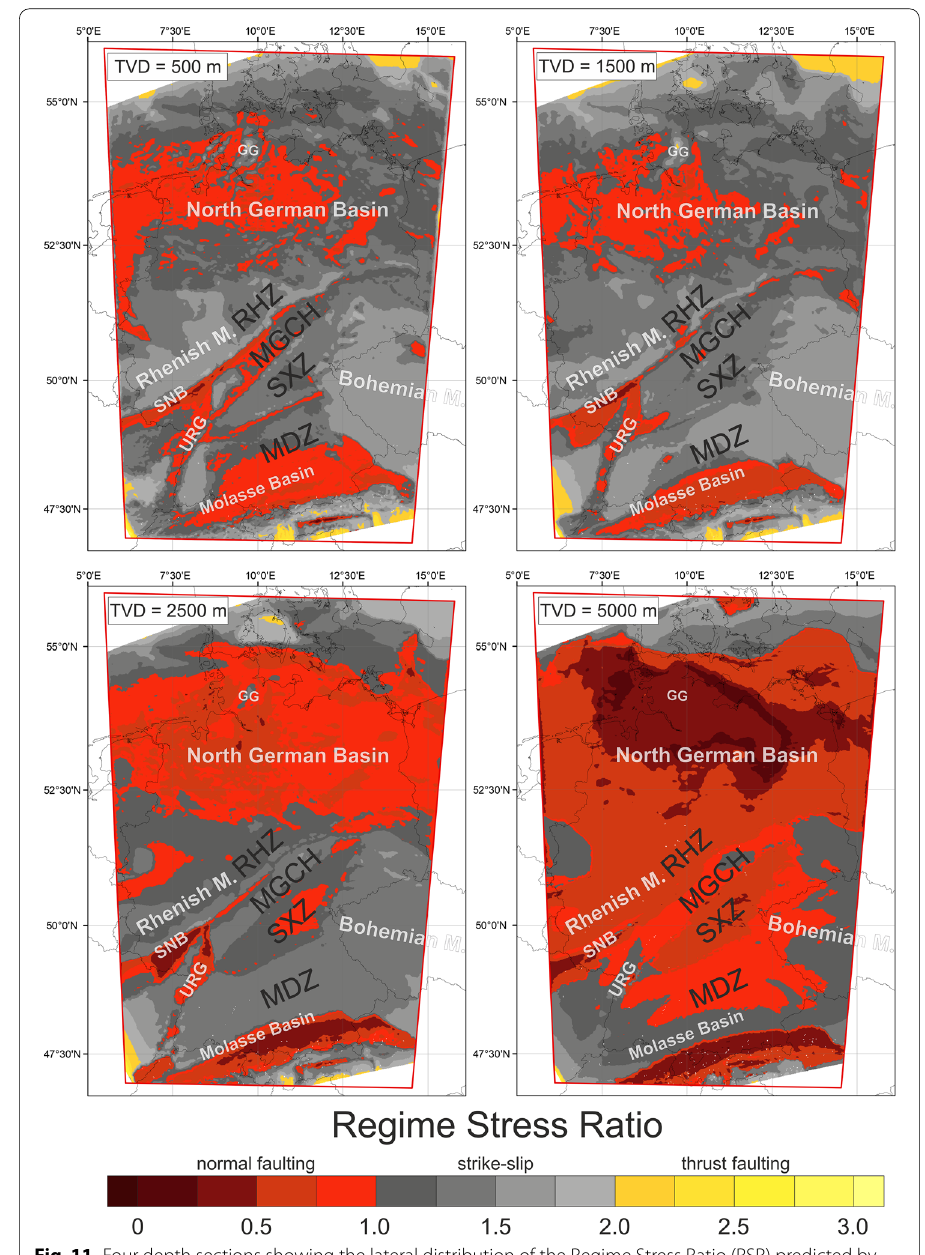
Fig. 11 Four depth sections showing the lateral distribution of the Regime Stress Ratio (RSR) predicted by the model. TVD—true vertical depth. Black titles (details in Fig. 1d): MDZ—Moldanubian Zone, MGCH—Mid German Crystalline High, RHZ—Rhenoherzynian Zone, SXZ—Saxothuringian Zone. White titles (details in Fig. 1c): GG—Glückstadt Graben, M—Massif, SNB—Saar–Nahe Basin, URG—Upper Rhine